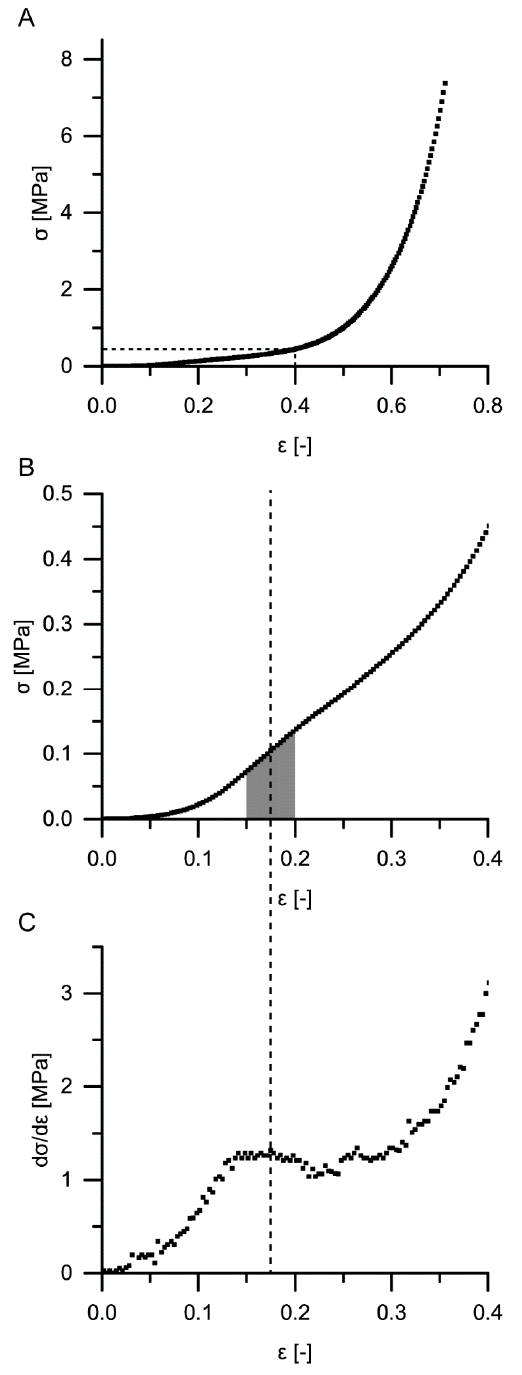
Figure 7. Exemplary stress–strain curves ( A , B ) and slope–strain curve ( C ) of quasistatic compression tests (one loading stage) of S. giganteum bark samples (strain rate 0.1 min − 1 ). ( A ) Whole stress–strain curve. ( B ) Enlarged detail of this stress strain curve, until 40% strain. The grey area marks one of the two methods to derive a structural Young’s modulus from the stress–strain curves (slope of the best-fit line between 15% and 20% strain). The dashed lines in ( B ) and ( C ) refer to the second method, namely the strain at which the maximum slope until 20% strain is observed in ( C ), where the slope of the stress strain curve from ( B ) is plotted against the strain, allowing to extract the maximum slope until 20%